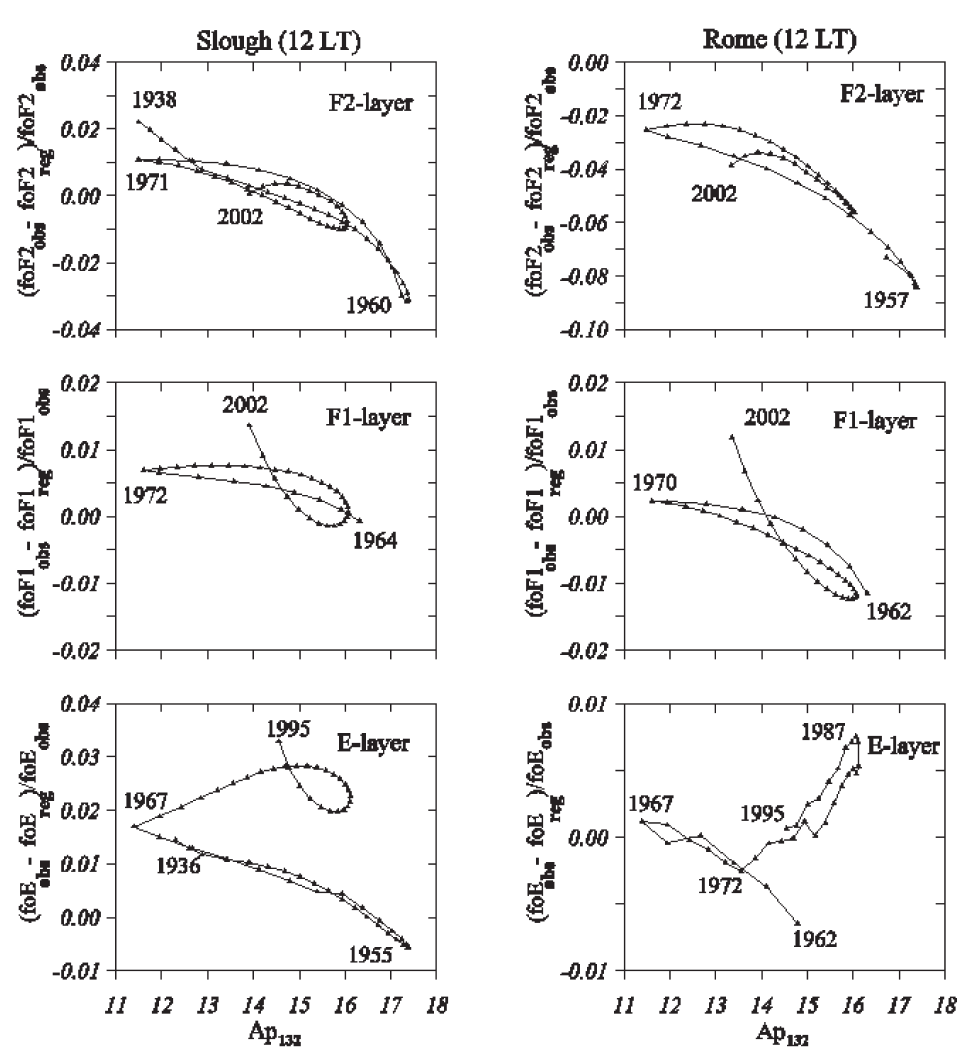
Fig. 3. Relationships between δ foF 2, δ foF 1, and δ foE and Ap 132 variations for Slough and Rome. Notice that the change in the type of the dependences appeared earlier in the E -layer and later in the F 1 and F